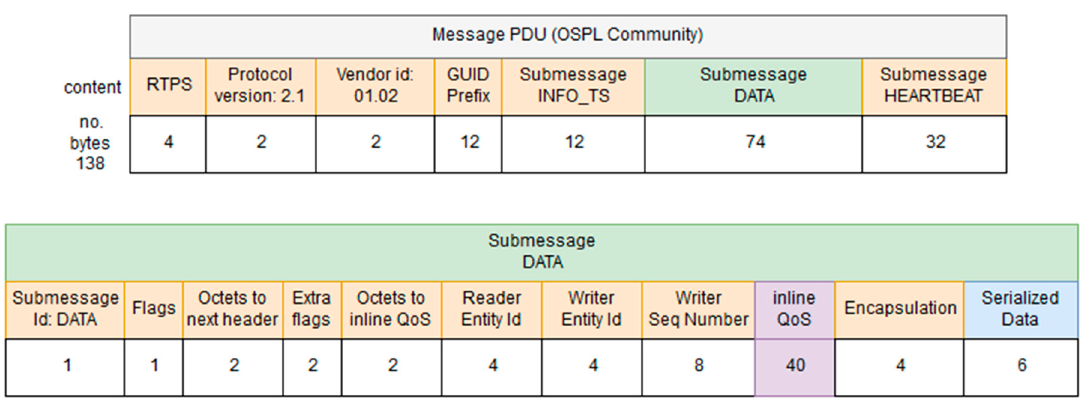
Figure 3. Message PDU with Open Splice DDS Community version.